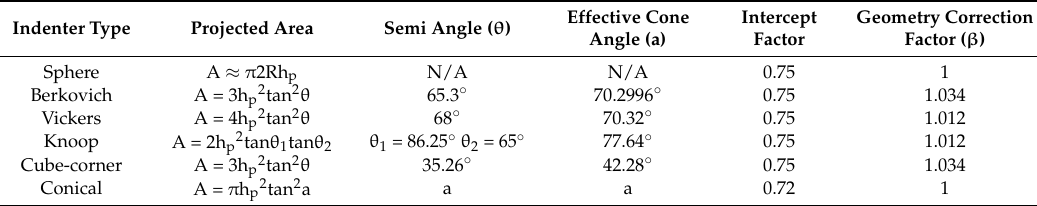
Table 1. Parameters of different indenters [17].